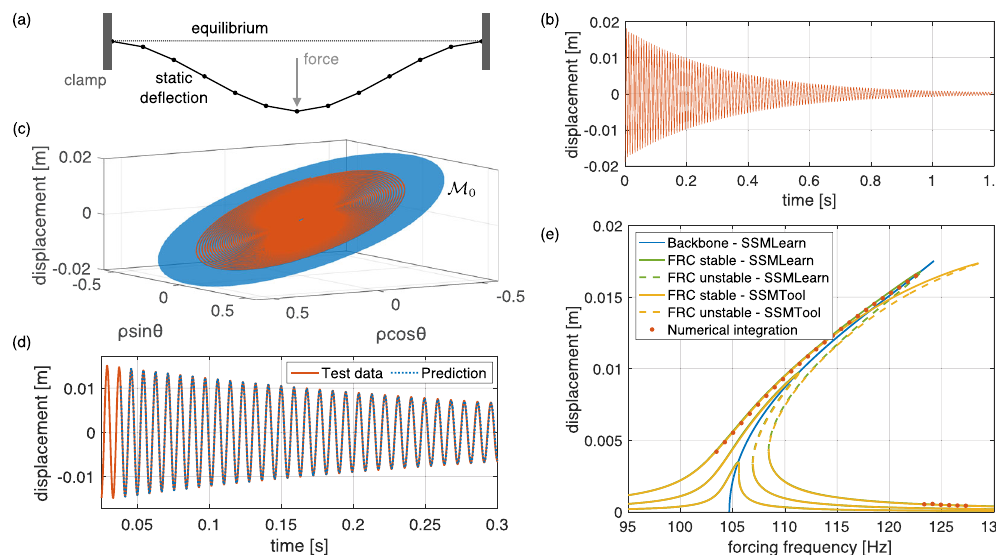
Fig. 4 Construction of a data-driven nonlinear reduced-order model on the slowest SSM of a von Kármán beam. ( a ) System setup and the initial condition for the decaying training trajectory shown in ( b ) in terms of the midpoint displacement. ( c ) The SSM, M along with the reconstructed test trajectory in extended normal form coordinates. ( d ) Zoom of the prediction of the reduced order model for the test trajectory not used in learning M 0 . ( e ) Closed-form backbone curve and forced response curve (FRC) predictions ( ϵ > 0, ℓ = 1) by SSMLearn are compared with analytic FRC calculations performed by SSMTool 36 and with results from numerical integration of the forced-damped